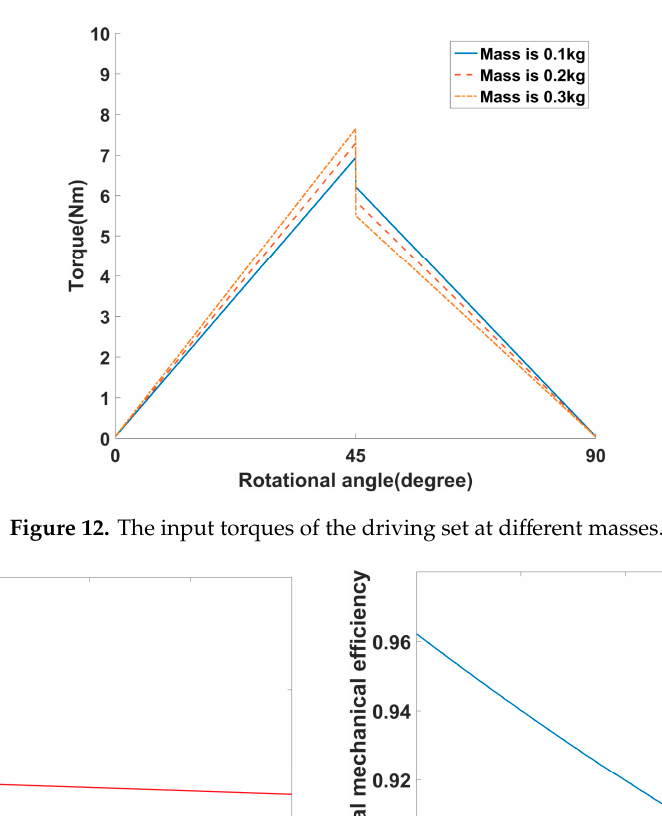
Figure 11. The input torques of the driving set at different rotational speeds and at a load pressure of 8 MPa.